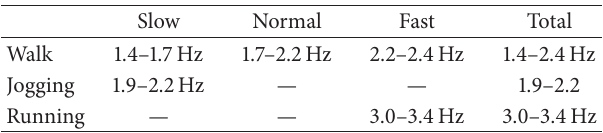
Table 2: Frequency range (Hz) for different patterns of movement (adapted from